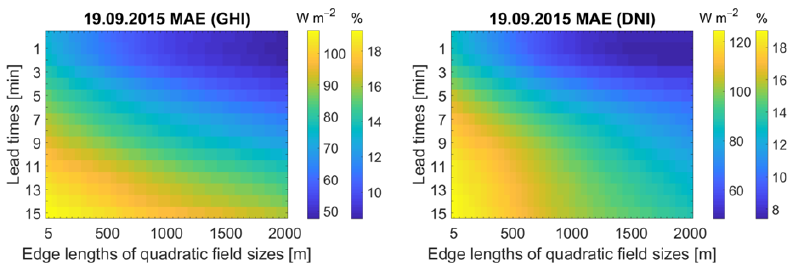
Figure 2. Absolute and relative mean absolute error of the WobaS-4cam system for GHI and DNI for various lead times and field